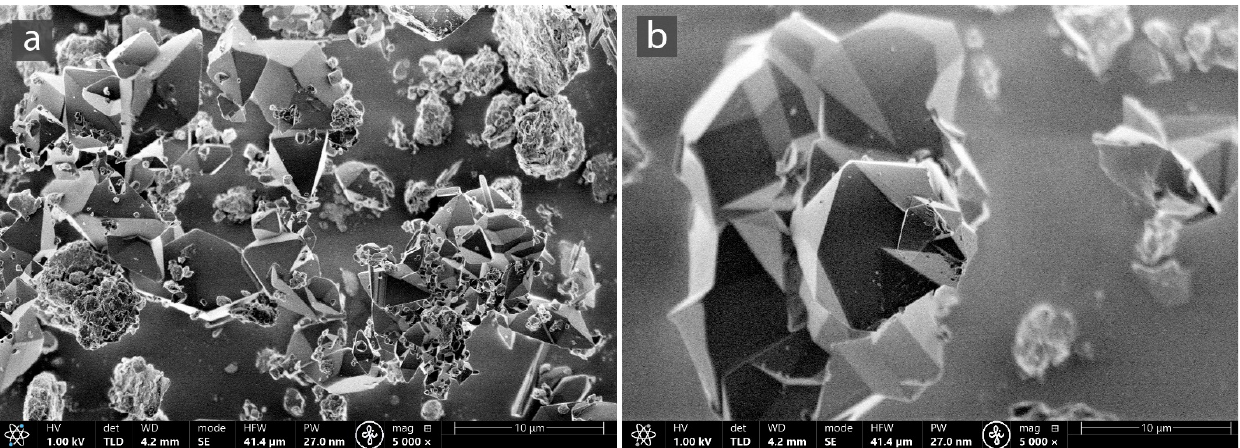
Figure 7. SEM image of ( a ) UTSA-16, ( b ) UTSA-16-Mt-15.